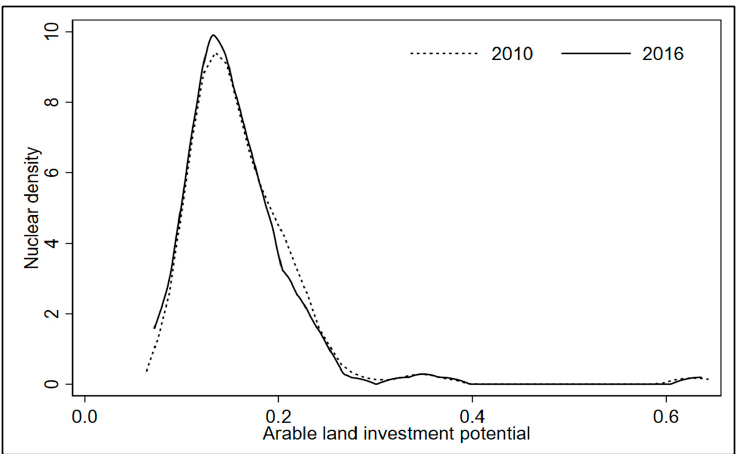
Figure 10. Kernel density estimation of arable land investment potential of countries along “the belt and road initiative”.